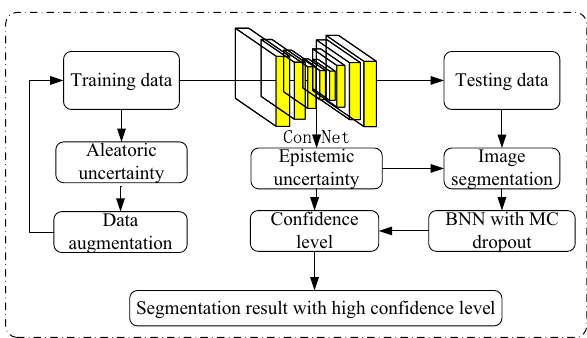
Fig. 1 Flowchart of epistemic and aleatoric uncertainties reduction method with rotation variation for medical image segmentation with